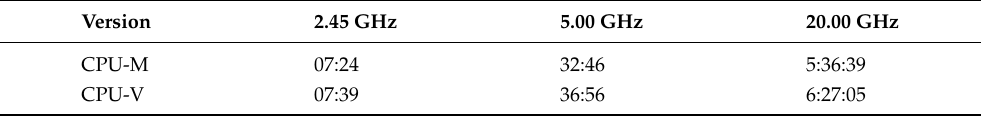
Table 11. Computing times obtained in serial form with the CPU, expressed in mm:ss, for the parabolic reflector